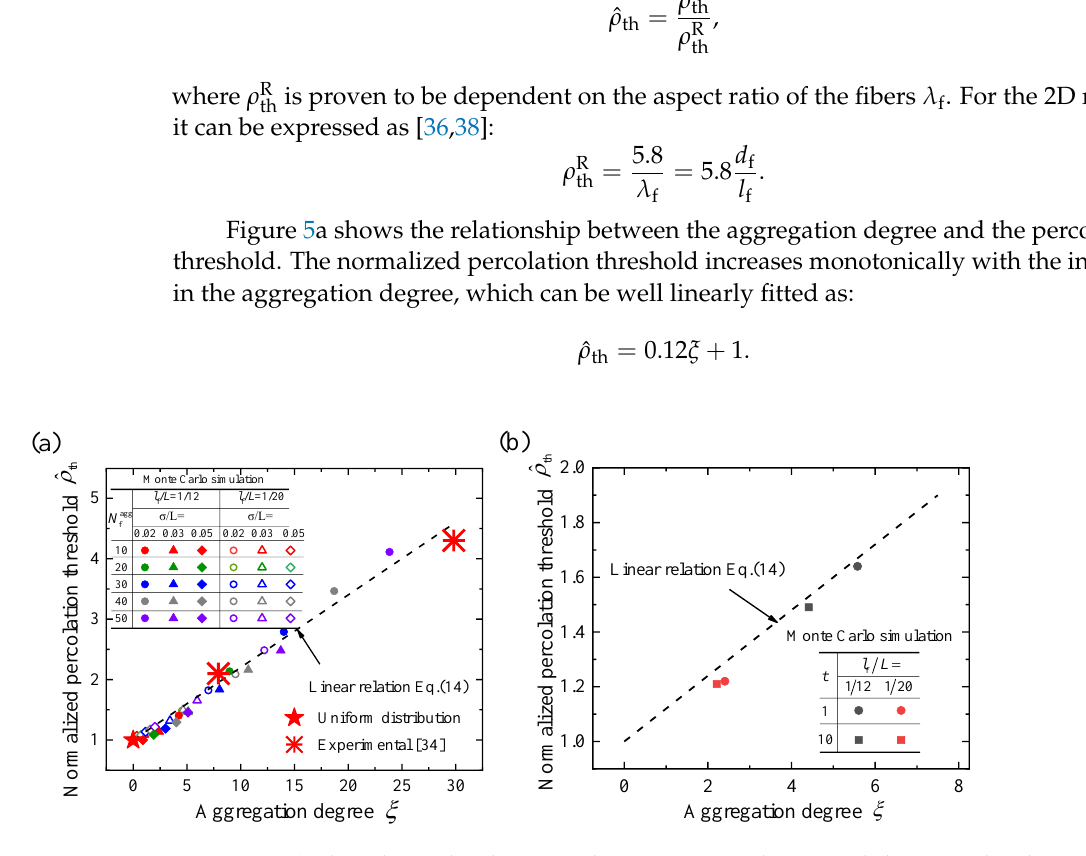
Figure 5. ( a ) The relationship between the aggregation degree and the normalized percolation threshold and ( b ) the relationship between the aggregation degree and the normalized percolation threshold for fibers with different distributions.